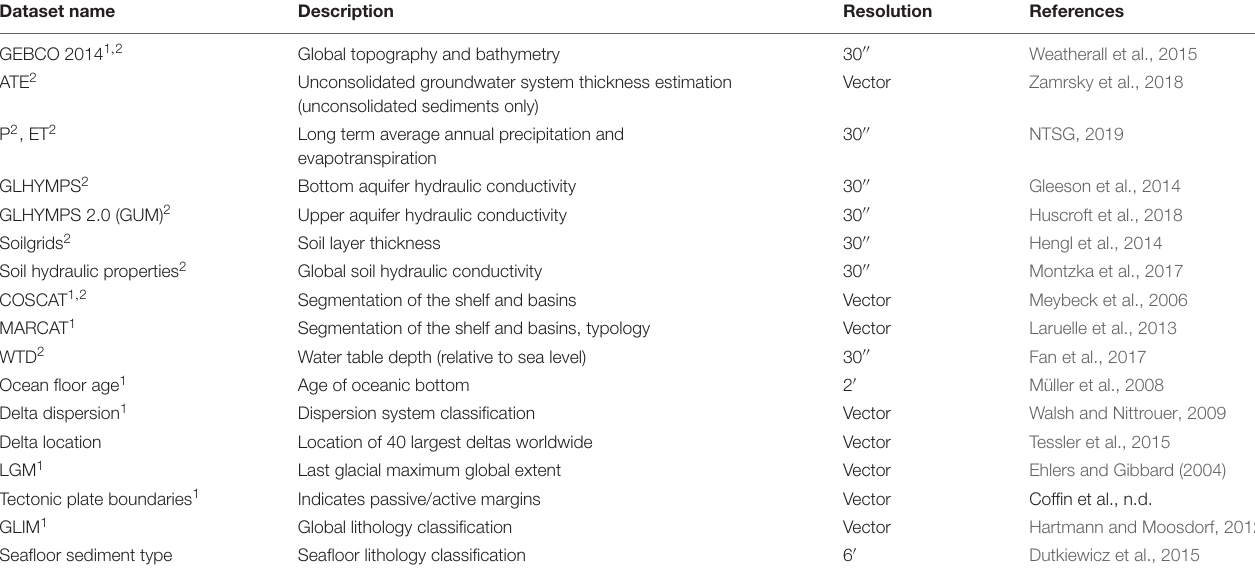
TABLE 1 | Global datasets collected and used as input.